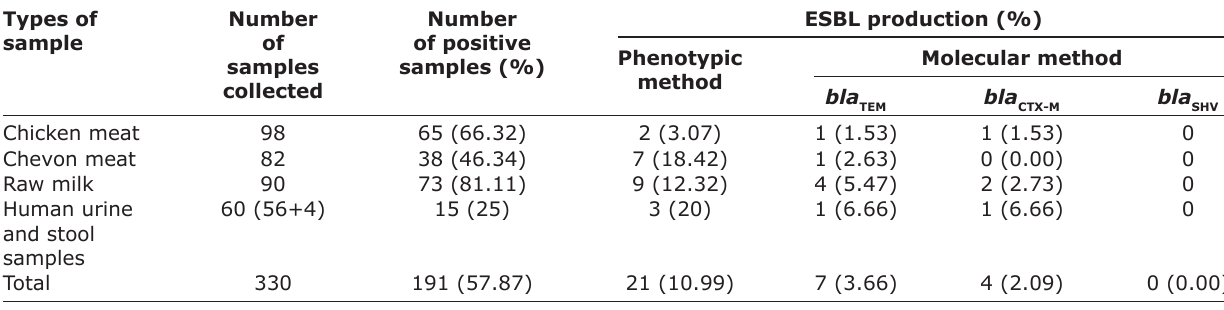
, bla , and bla gene in chicken meat, chevon meat, milk, and human TEM CTX-M SHV